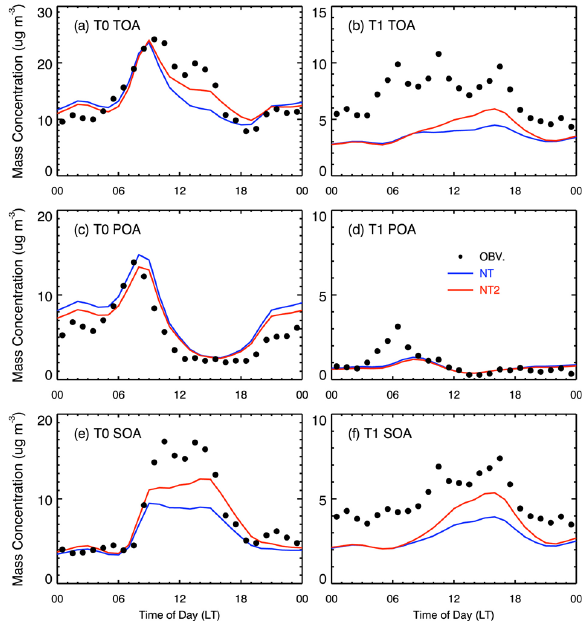
Figure 9 Fig. 9. Same as Fig. 5, except that the blue line represents the NT- SOA model and the red line denotes the NT2-SOA model.